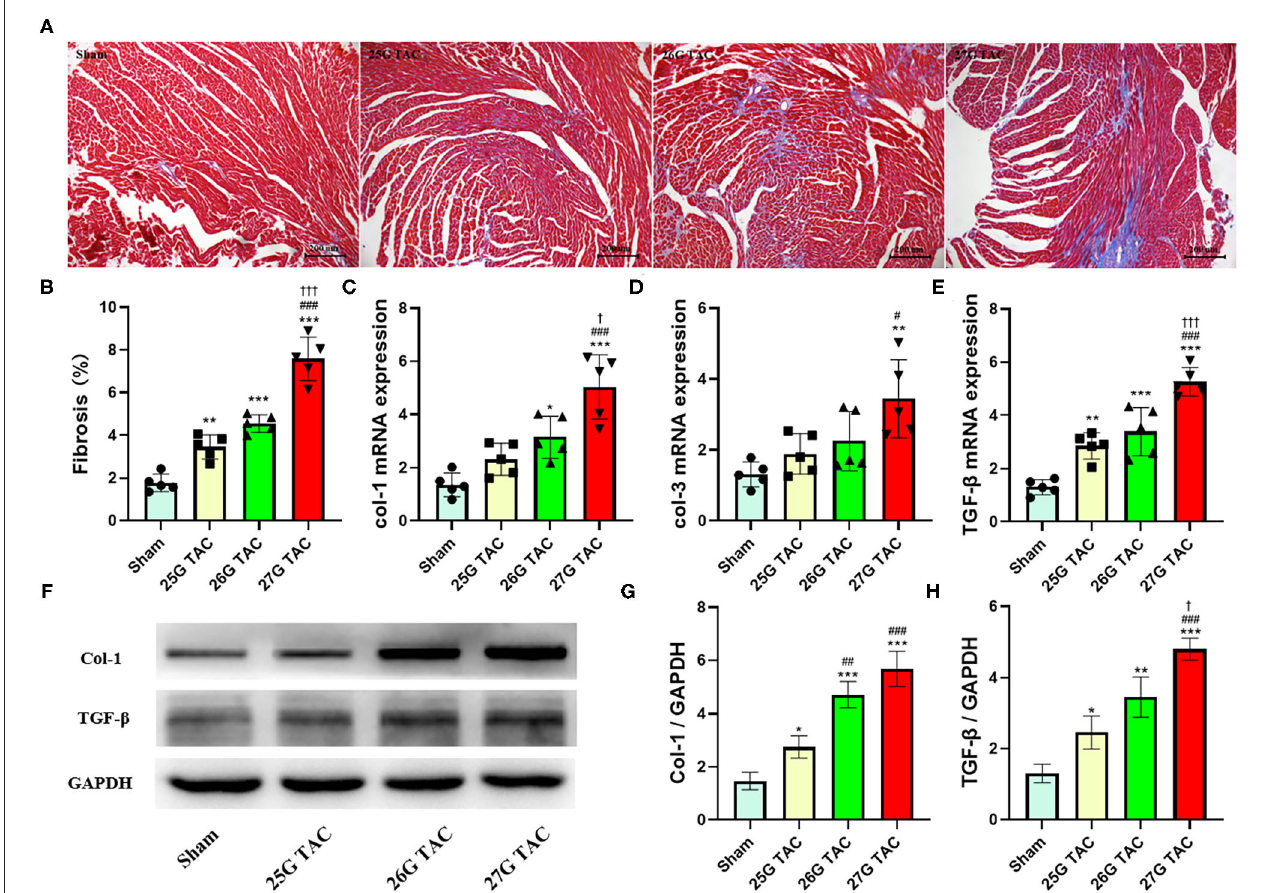
FIGURE 4 | 25, 26, and 27G TAC induced different degrees of cardiac fibrosis in C57BL/6N mice. (A) Representative images for cardiac fibrosis. (B) Quantification of cardiac fibrosis. Apical left ventricular gene expression of (C) col-1, (D) col-3, (E) TGF- β . (F–H) Western blot analysis of col-1 and TGF- β . * P < 0.05, ** P < 0.01, and *** P < 0.001 vs. sham, # P < 0.05, ## p < 0.01, ### p < 0.001 vs. 25G, † P < 0.05, ††† P < 0.001 vs. 26G TAC by one-way ANOVA with Tukey’s